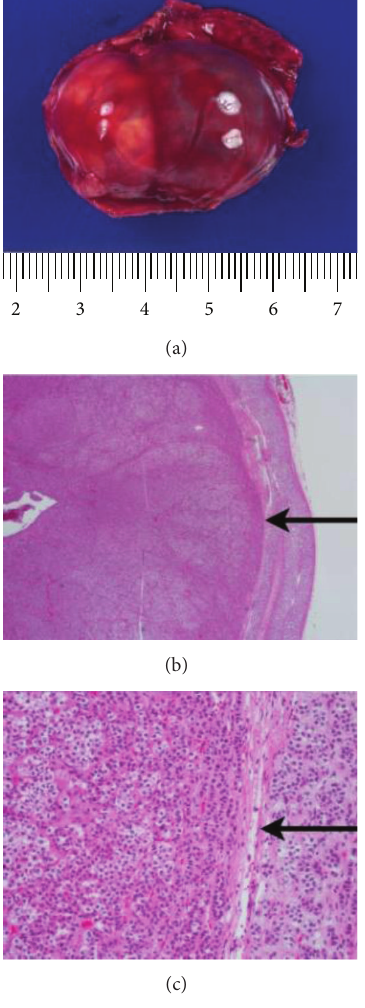
Figure 1: (a) Gross photograph of resected adrenal mass. (b) Low power photomicrograph of adrenocortical tumor. The tumor is encapsulated (arrow) and has a pushing border, with compressed normal adrenal cortex on the right. (H&E, 20x). (c) High power photomicrograph of adrenocortical tumor. Arrow is pointing to a thin fibrous capsule. The tumor has similar cytologic features to the normal adrenal seen on the right. Features that have been associated with malignancy (capsular invasion, necrosis, and increased mitotic activity) are not present (H&E,